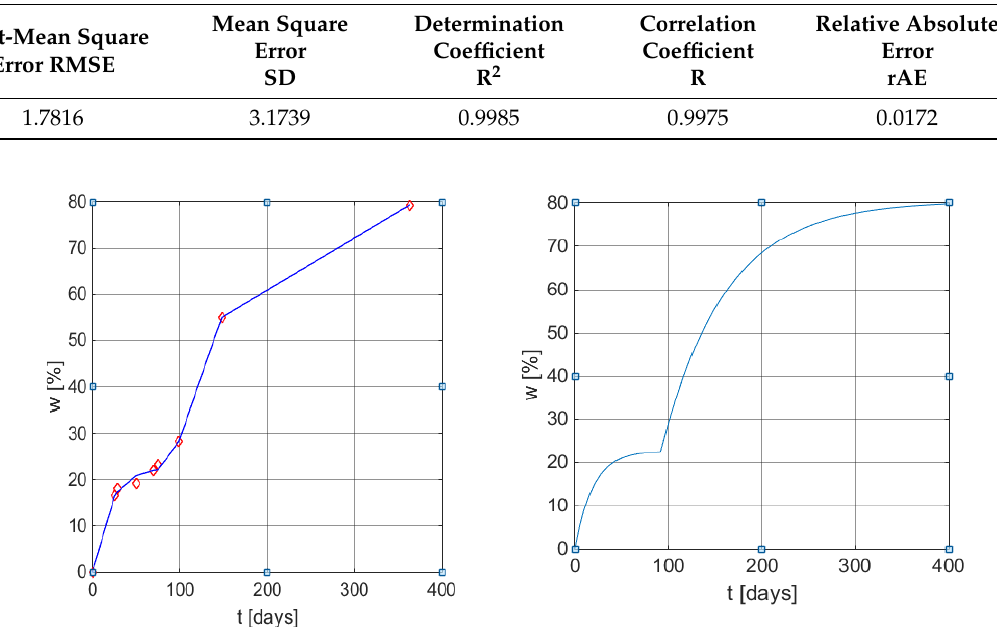
Table 6. Statistical indicators for the accuracy of model (6) in the case of experimental data from [43]. Model